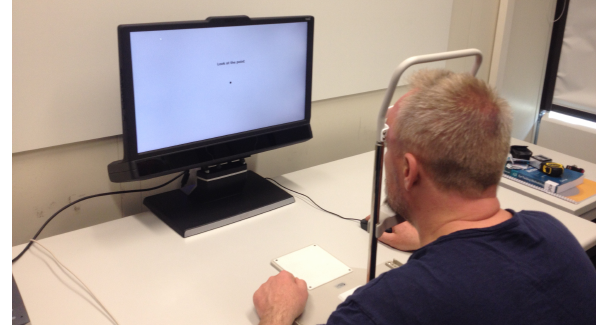
Figure 6 . Experimental setting featuring the Tobii TX300 eye tracker and chin